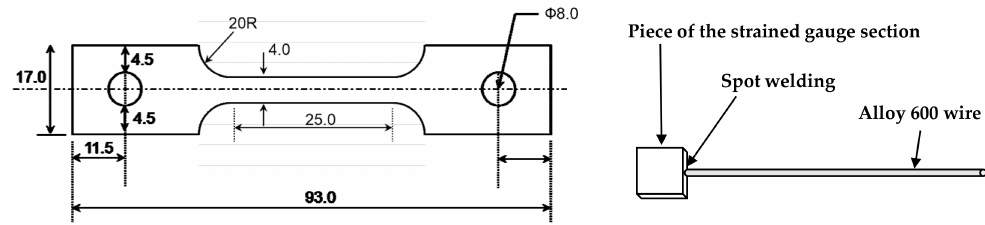
Figure 2. Dimensions and preparations of the tensile-strained specimens for the electrochemical tests.